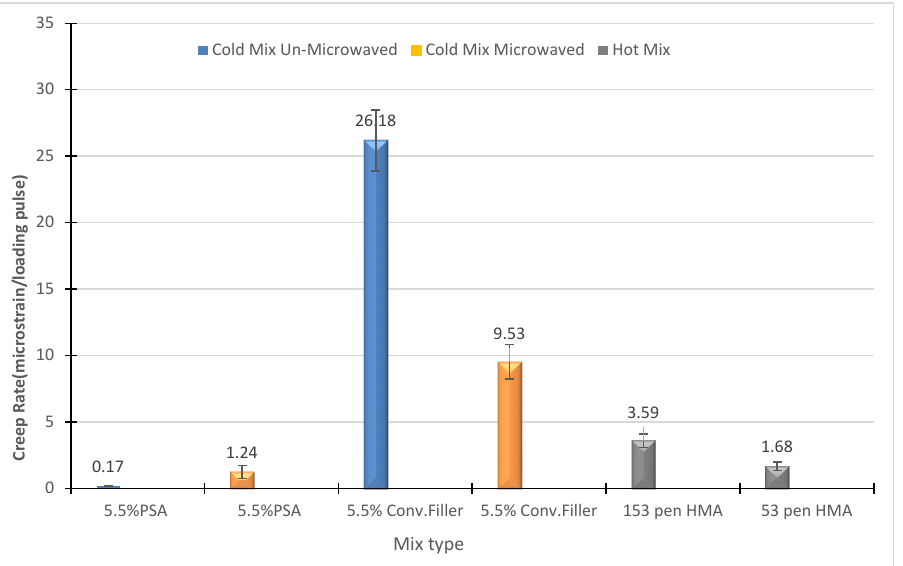
Figure 10. Effect of MW treatment on creep rate.